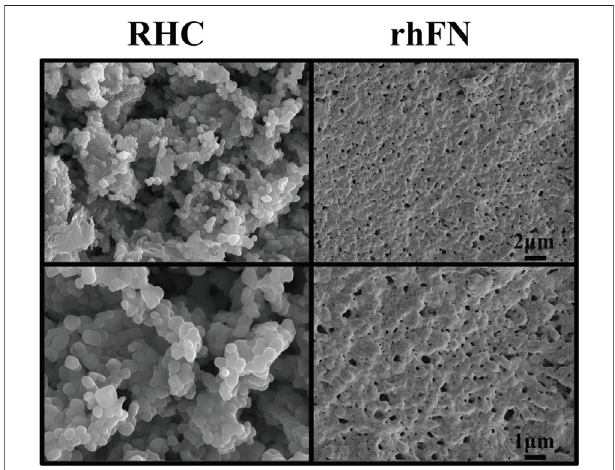
FIGURE 2 | SEM images of RHC and